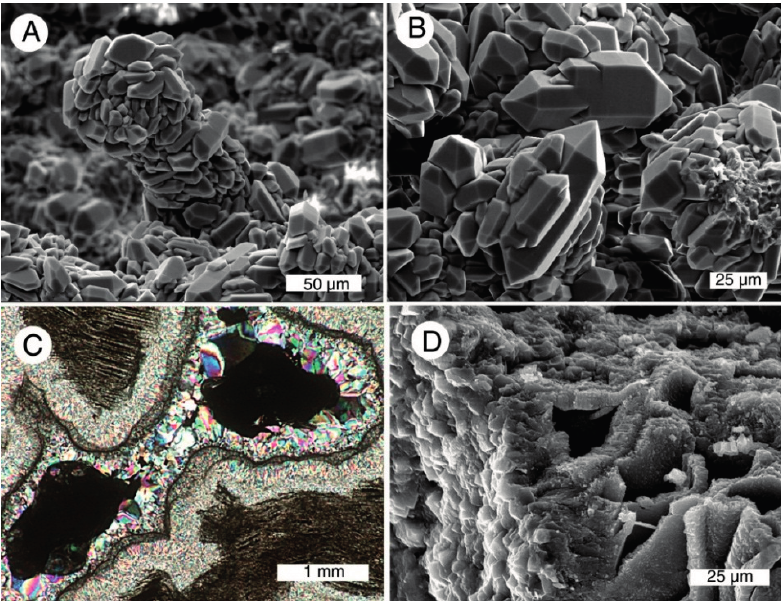
Figure 8. Examples of quartz. ( A ) Quartz crystals coating a single tracheid, location 6; ( B ) Euhedral quartz on transverse surface, location 6; ( C ) Polarized transmitted light view of opal-CT wood, with rot pockets containing microcrystalline chalcedony overgrown by quartz crystals. Central cavities remain open, location 7; ( D ) Oblique transverse view of opal-CT mineralized wood, showing layer of crystalline quartz coating surface of a fracture, location